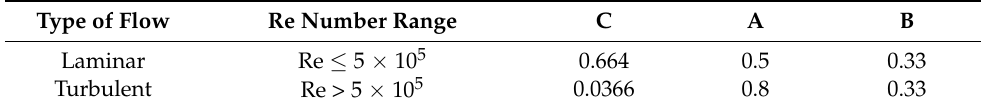
Table 3. Nusselt equation coefficients for laminar and turbulent